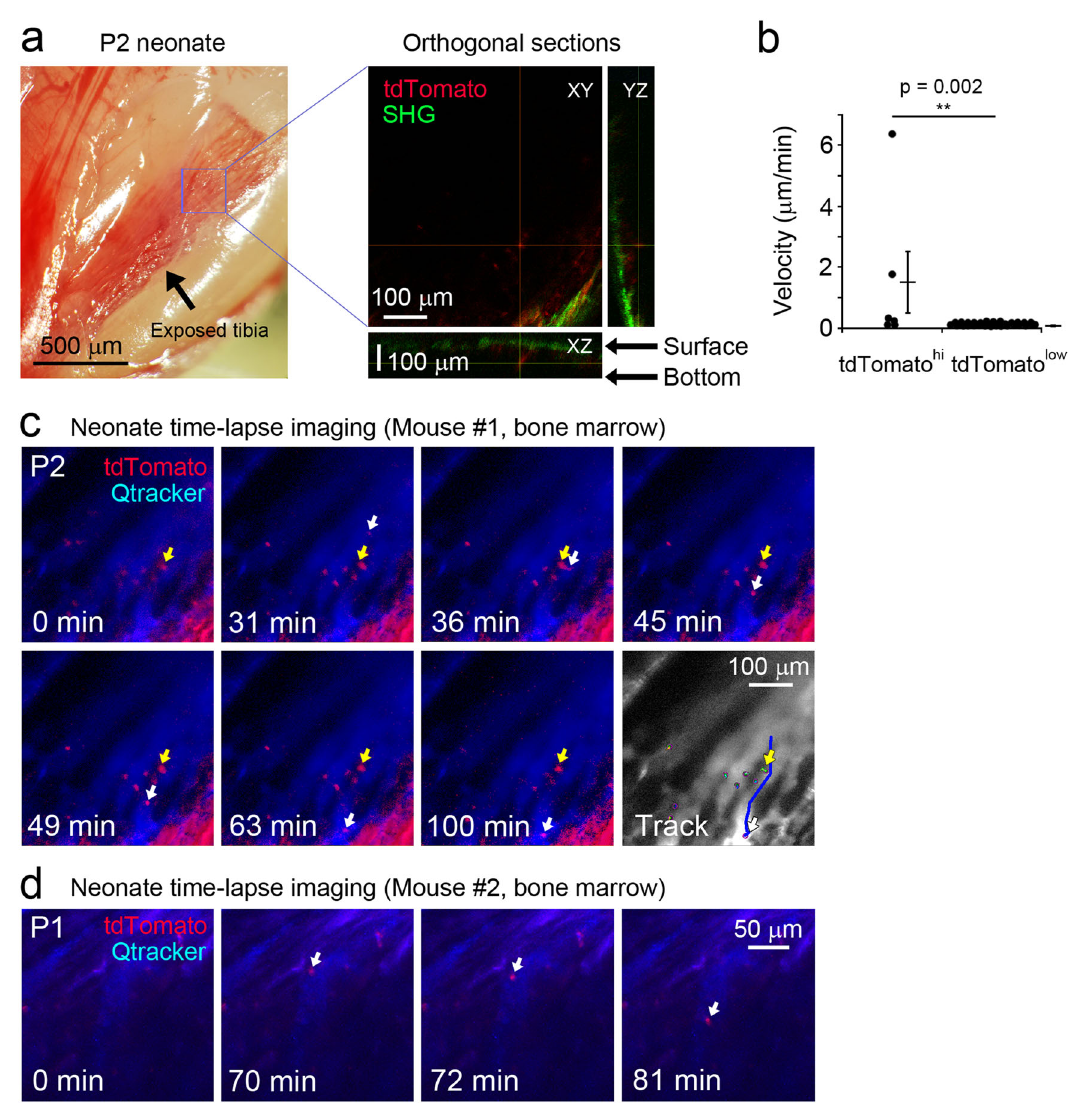
Fig. 5 Intravital time-lapse imaging of Hlf-tdTomato-labeled cells in the neonatal tibial bone marrow. a Tibial bone was exposed on postnatal day 2 (left). Orthogonal view image of the tibial bone marrow (right). See also Supplementary Movie 4. b Quantitative comparison of the migration dynamics between Hlf-tdTomato hi cells (six cells from three mice) and Hlf-tdTomato low cells (24 cells from three mice) in neonates. c Time-lapse images of developing (P2) bone marrow showing migration of an Hlf-tdTomato hi cell in the blood vessels. White arrows indicate migrating cells in the blood vessel and yellow arrows indicate stable cells outside the blood vessels. See also Supplementary Movie 5. d Another example of an Hlf-tdTomato hi cell migrating in the bone marrow blood vessels in a neonatal mouse